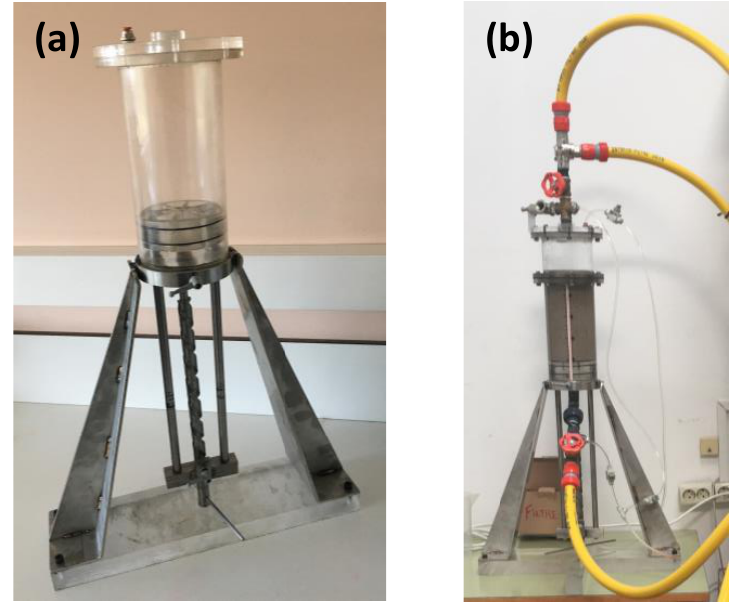
Figure 1. ( a ) Experimental filter built for the experiment before and ( b ) after the insertion of the sand bed and the necessary fittings for conducting the experiment.